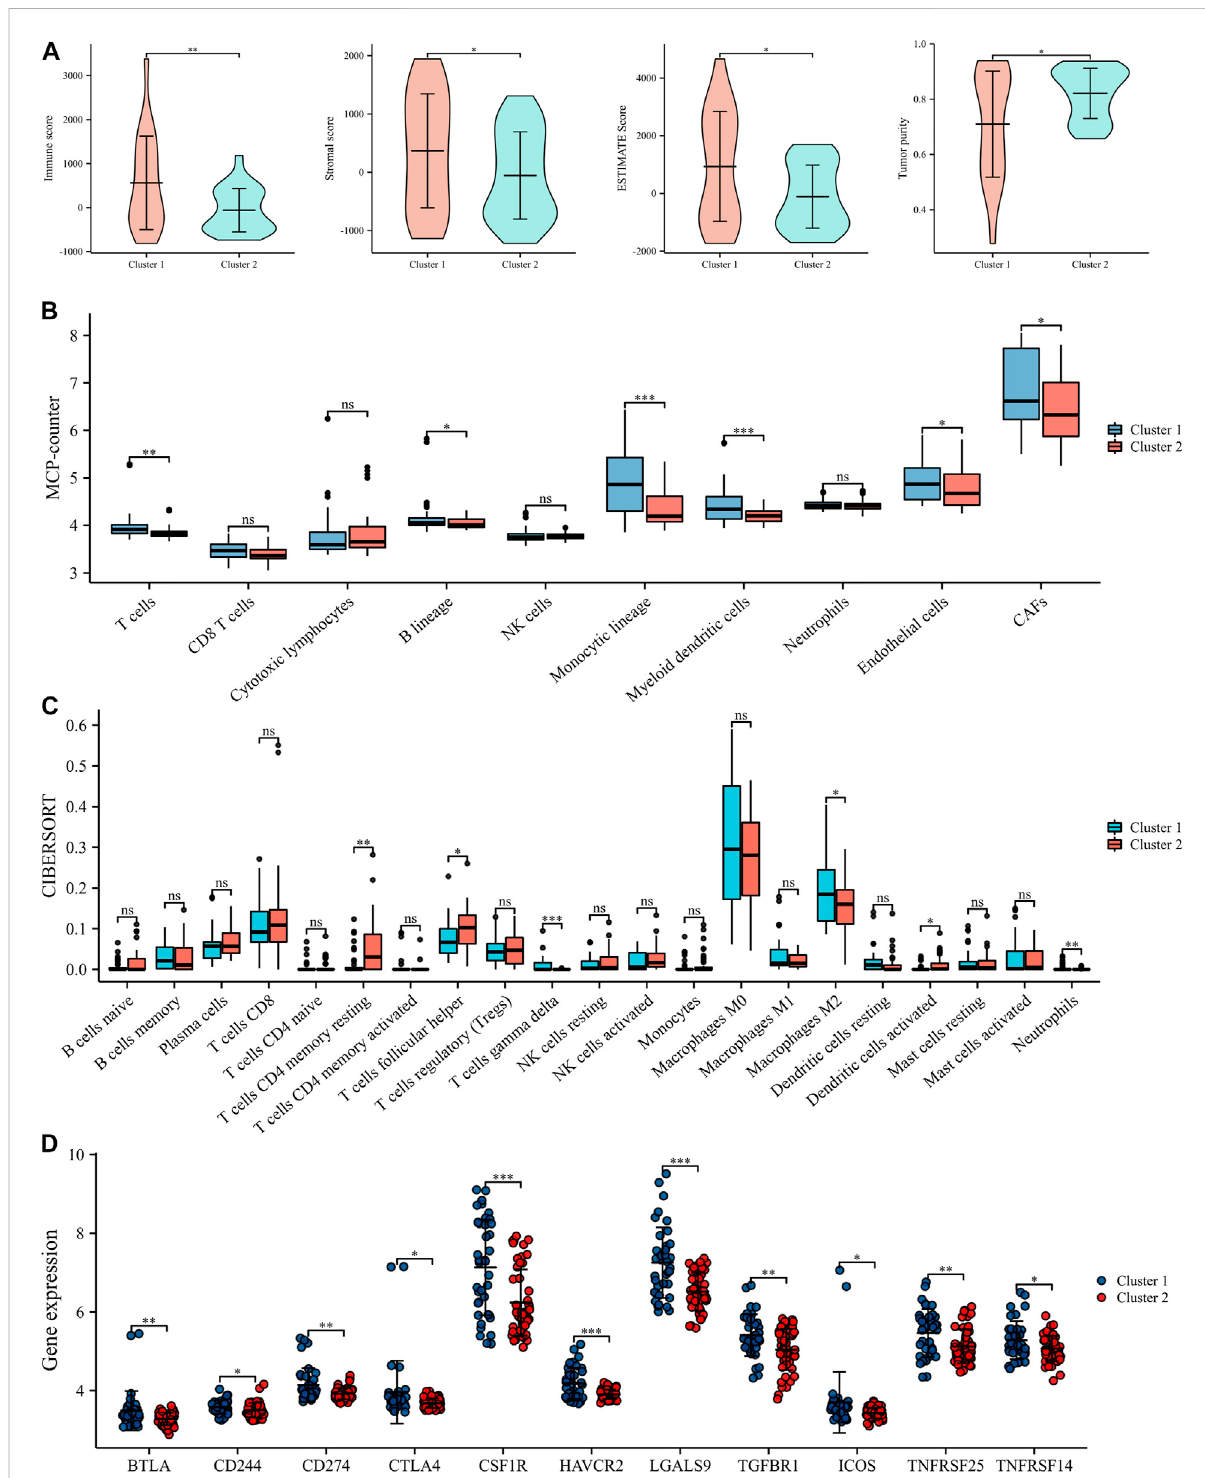
FIGURE 4 Tumor immune microenvironment (TIME) evaluation in different lactate regulation patterns (A) . TIME scores by ESTIMATE algorithm (B) . The expression levels of 10 immune in fi ltrating cells by MCP counter (C) . Abundance of 22 immune in fi ltrating cells by CIBORSORT (D) . The expression levels of ICPs in different lactate regulation patterns. * p < 0.05; ** p < 0.01; *** p <